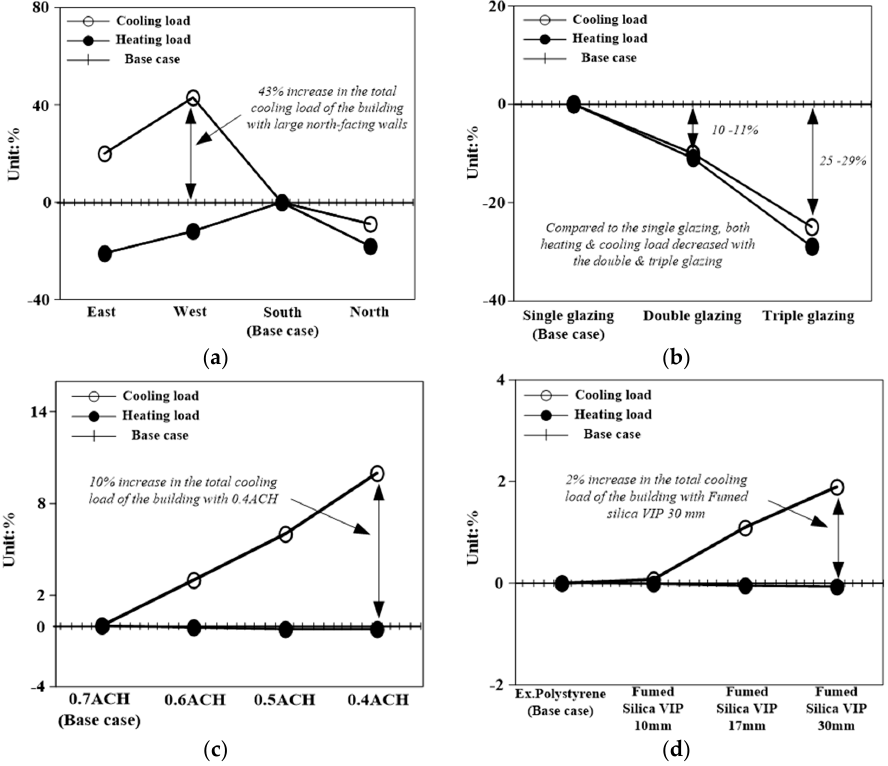
Figure 7. The comparisons of the heating and cooling loads of Unit B with design alternatives. ( a ) Building Orientation; ( b ) Window Glazing; ( c ) Infiltration Rate; ( d ) Building Insulation.